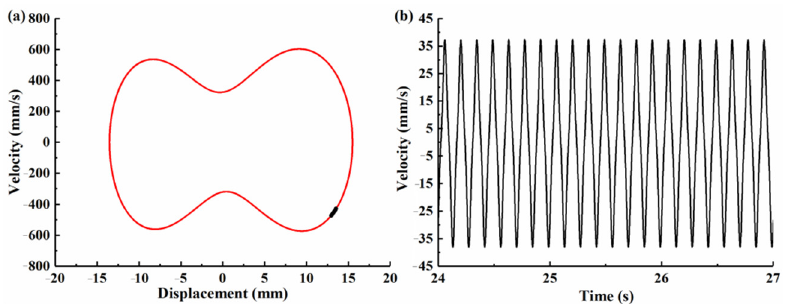
Figure 11. Simulation results for CBH-C under excitation frequency f = 7.1 Hz. ( a ) Phase plane portrait and Poincaré map. ( b ) Output voltage histories.